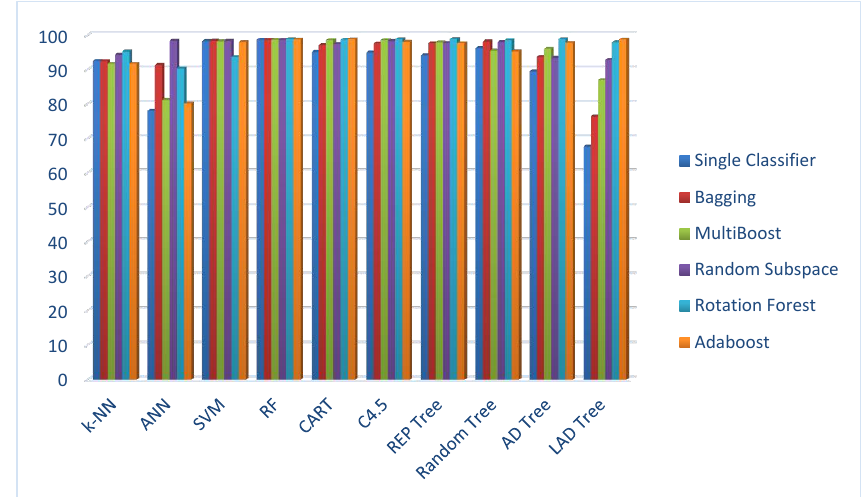
Figure 1. Classification accuracies of machine learning methods as single classifiers and in combination with one of five ensemble machine learning methods.